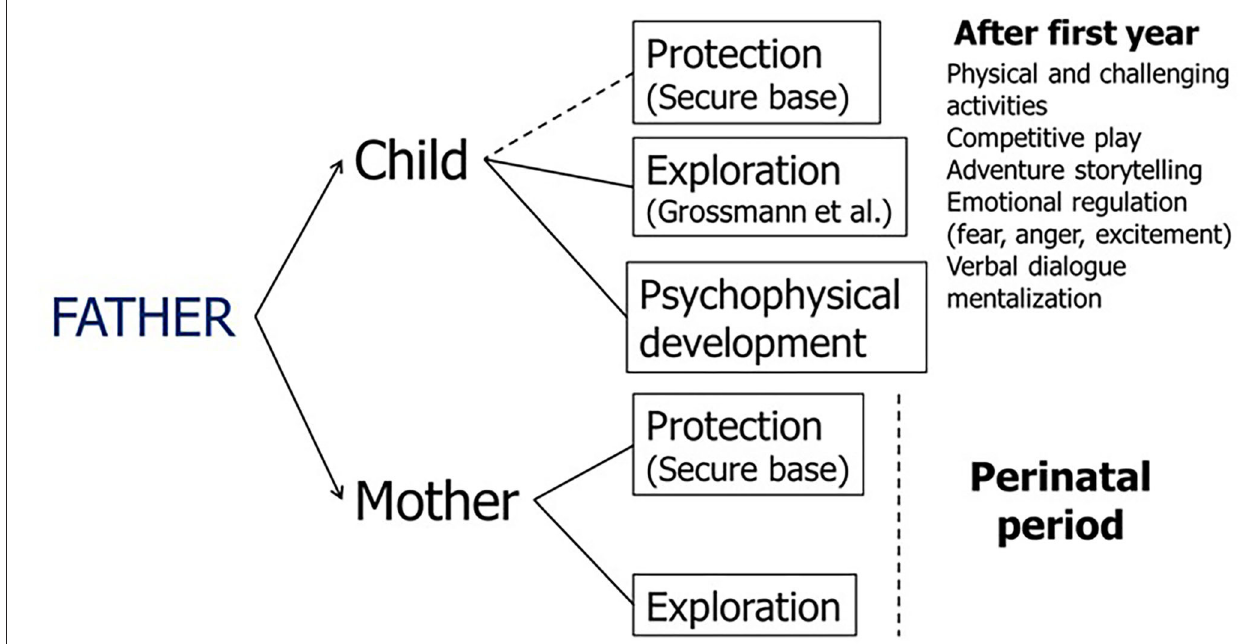
FIGURE 1 | Paternal attachment